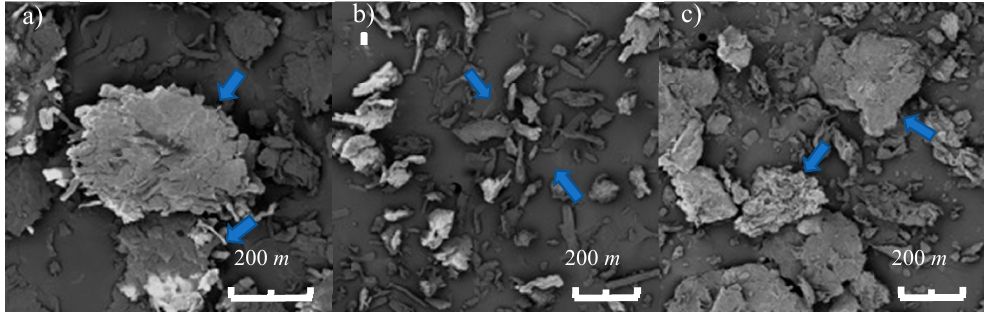
Figure 3. Scanning electron microscopy (SEM) micrographs at scale 200 μ m for powders of the different excipients. ( a ) CC; ( b ) CMCC; ( c ) BC.